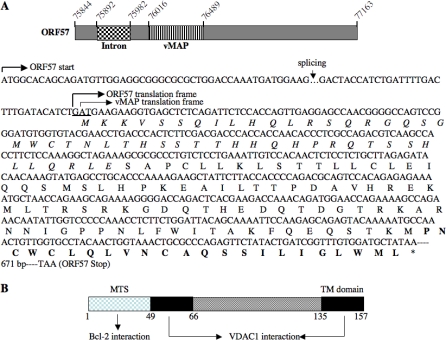
Genomic Localization and Protein Organization of γHV-68 vMAP(A) vMAP is encoded within the ORF57. (Top diagram) The vMAP genomic localization is shown within the ORF57 sequence. Numbers indicate the nucleotide position according to Entrez accession number U97553. The grid box represents a 90–base pair intron of ORF57 and the box with vertical lines represents vMAP (M8). (Bottom diagram, sequence) The first ATG denotes the start codon for ORF57 (arrow on the left). The coding sequence of vMAP is shown in reference to ORF57 and its amino acid sequence is listed below. The translation of vMAP has a +1 shift to ORF57 frame; thus, the vMAP amino acid sequence is completely different from the ORF57 amino acid sequence. The mitochondrion-targeting sequence (MTS) is italicized and the putative transmembrane (TM) domain is indicated by bold letters. An arrow (↓) over a gap (dots) indicates the splicing site where a 90–base pair of intron is removed [47]. *, stop codon.(B) vMAP protein organization. The N terminal sequence (aa 1–49) serves as a mitochondrial targeting sequence (MTS) as well as a Bcl-2-interacting region. Both the internal hydrophobic region (aa 50–66) and the putative transmembrane (TM) domain (aa 135–157) interact with VDAC1.